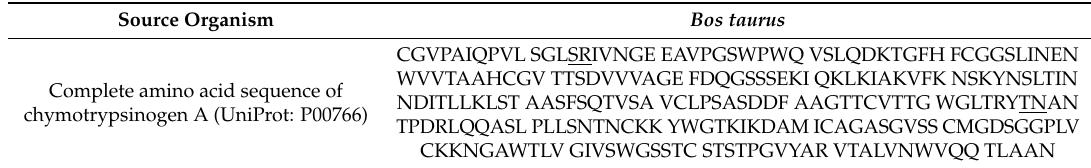
Table 1. Macromolecule information.